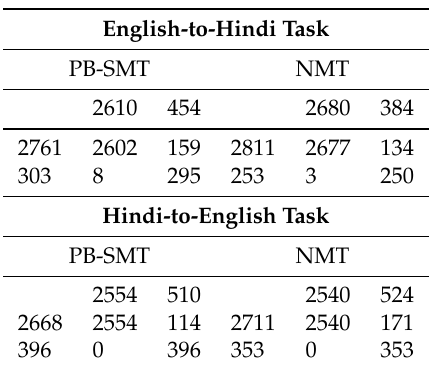
Table 6. Contingency